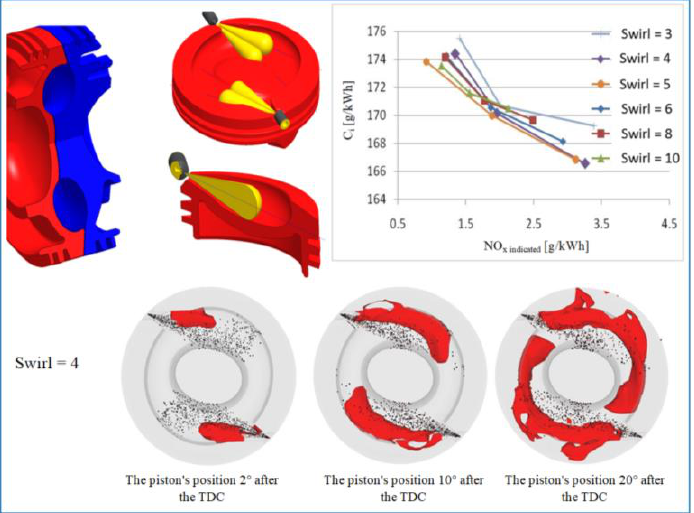
Figure 19. The combustion chamber 3 (toroidal shape) and its performances in virtual environment.